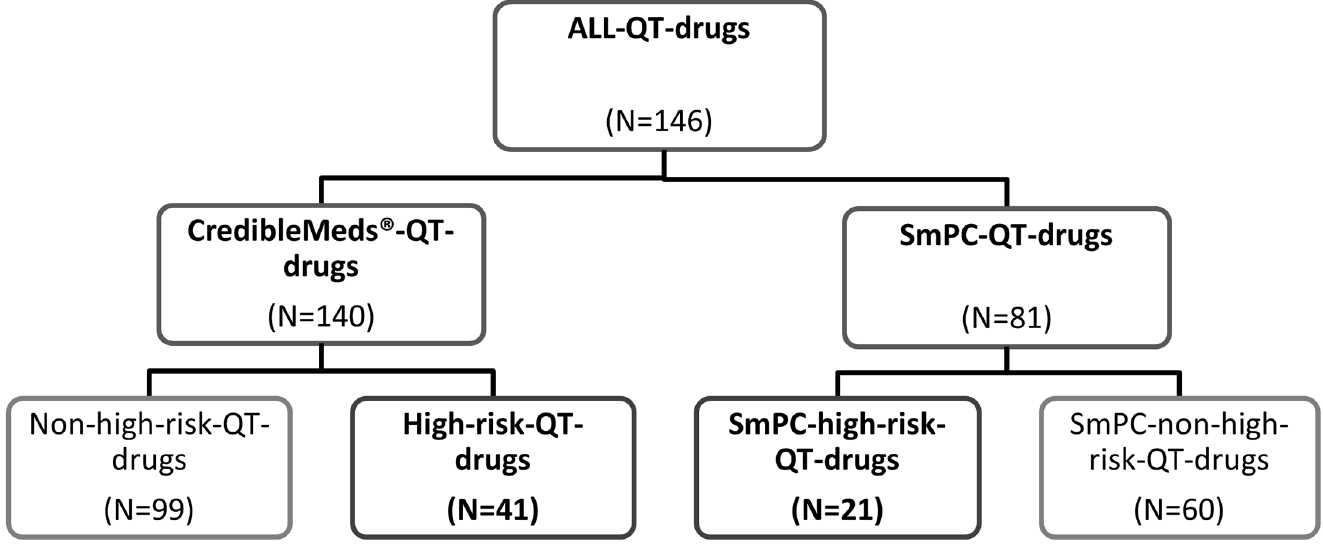
Fig 1. Classification of the QT-drugs according to CredibleMeds 1 and German SmPC with the respective subgroups. According to the classification of the QT-drugs used in this study the same drug can be counted in the right and in the left side of the panel. For the individual QT-drugs see in Table 1 and S1 and S2